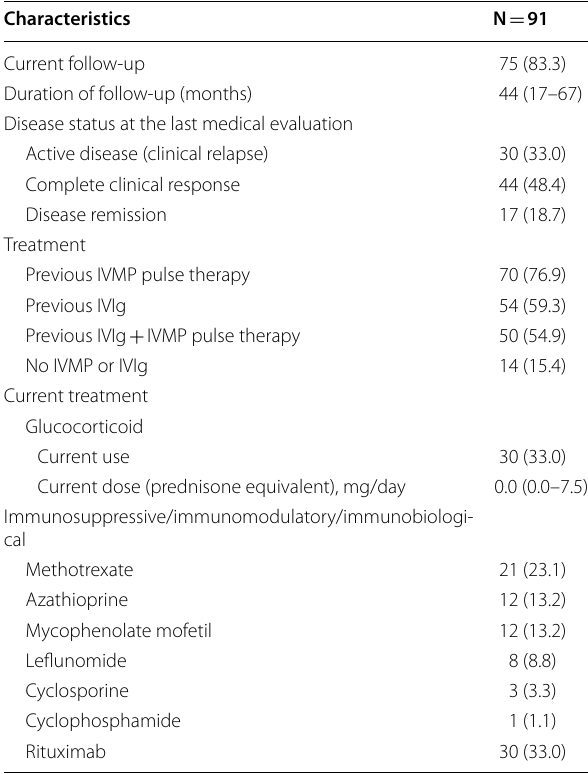
Table 2 Treatment characteristics and follow-up of 91 patients with